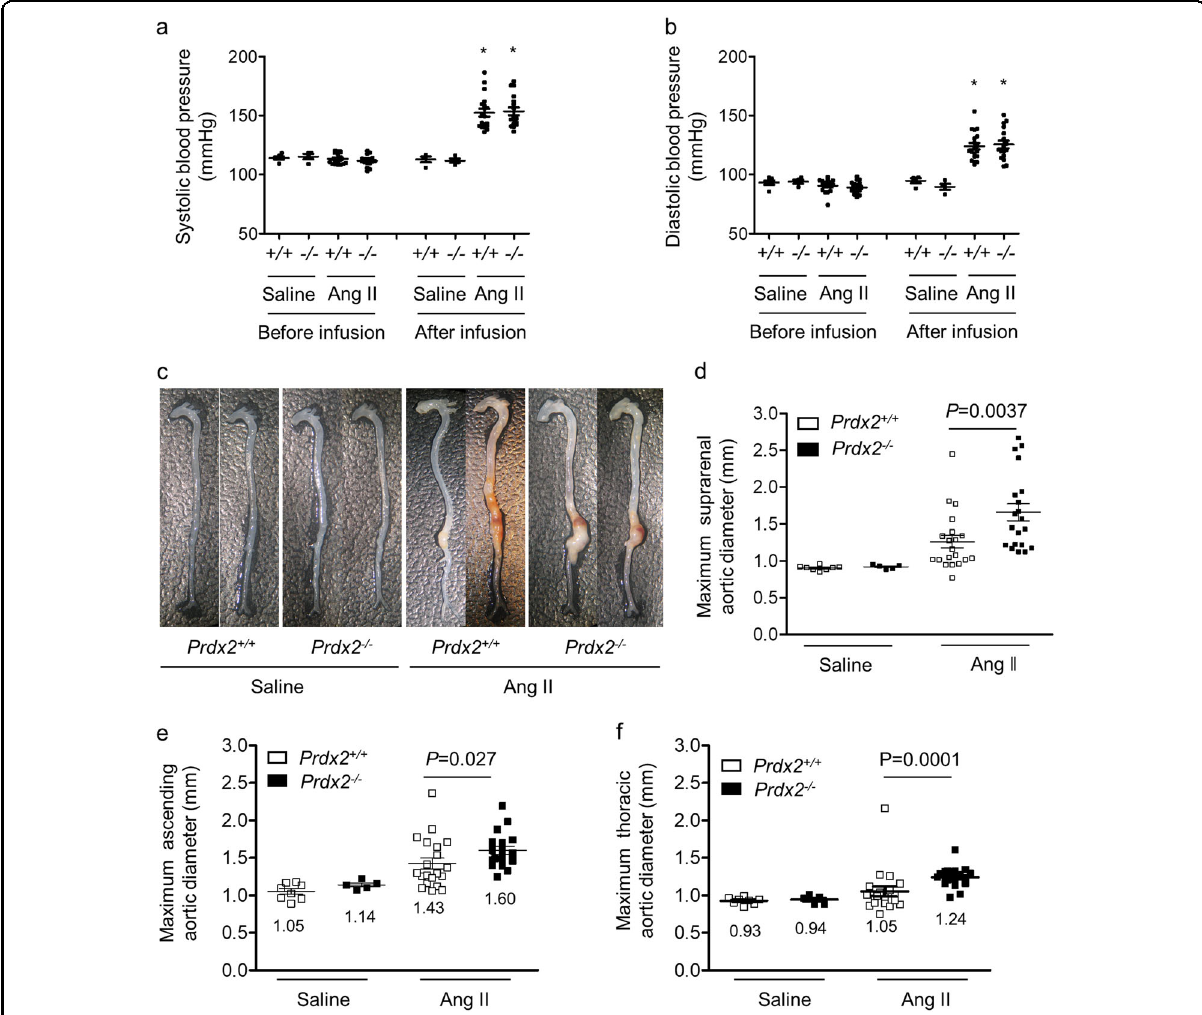
Fig. 3 De fi ciency of PRDX2 exacerbates Ang II-induced AAA without a change in blood pressure. a Systolic blood pressure in Prdx2 + / + and Prdx2 − / − mice infused with saline ( n = 4 – 6) or Ang II ( n = 17 – 18) at weeks 0 and 2. b Diastolic blood pressure in Prdx2 + / + and Prdx2 − / − mice infused with saline ( n = 4 – 6) or Ang II ( n = 17 – 18) at weeks 0 and 2. * P < 0.05 vs before infusion (two ‐ tailed Student ’ s t test for a and b ). c Representative macroscopic images of whole aortas from Prdx2 + / + and Prdx2 − / − mice infused with saline or Ang II for 4 weeks. d Quanti fi cation of the maximal suprarenal aortic diameter, e the maximal ascending aortic diameter, and f the maximal thoracic aortic diameter in Prdx2 + / + and Prdx2 − / − mice infused with saline ( n = 5 – 8) or Ang II ( n = 20) for 4 weeks. All data are presented as the mean ± SEM (nonparametric Mann – Whitney U test for d – f